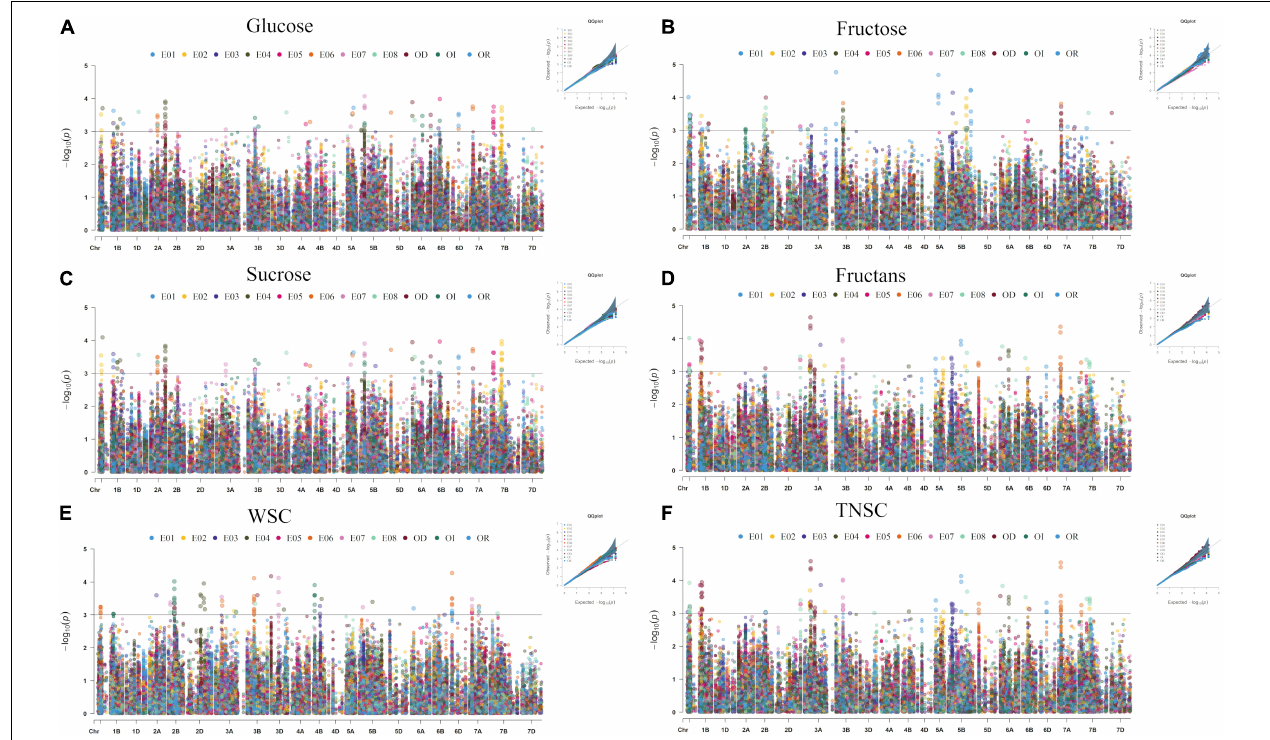
FIGURE 3 | Manhattan and quantile-quantile plots summarizing the GWAS results for glucose (A) , fructose (B) , sucrose (C) , fructans (D) , TNSC (E) , and WSC (F) in IWAMP of 301 bread wheat genotypes evaluated under eight distinct environments. The x -axis and y -axis refer to chromosomes and –log 10 ( p ) values for different traits, and the colors of dots refer to different